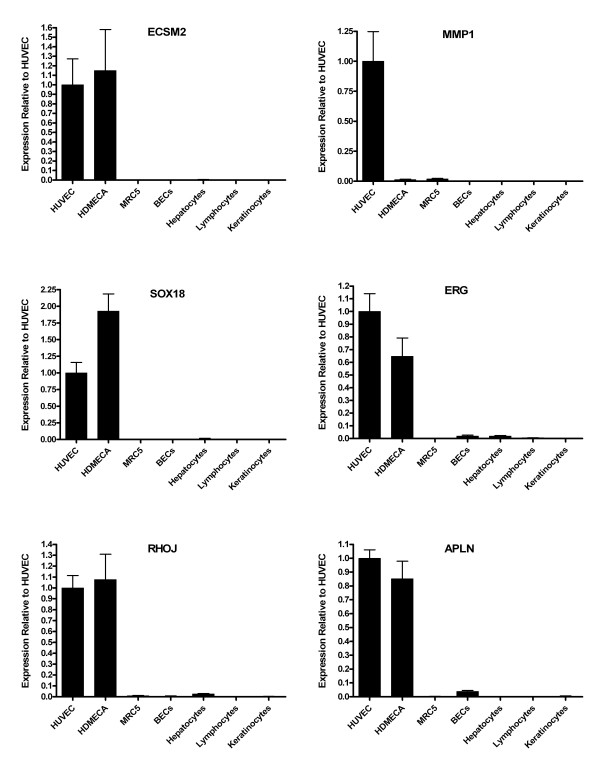
Real time PCR analysis of randomly chosen endothelial predicted genes across a range of cell types. Real time PCR was carried out on the predicted endothelial genes ECSM2, MMP1, SOX18, ERG, RHOJ and APLN. The graphs illustrate the power of the bioinformatics models as all genes examined were up regulated or specific to HUVECs and/or HDMECs.